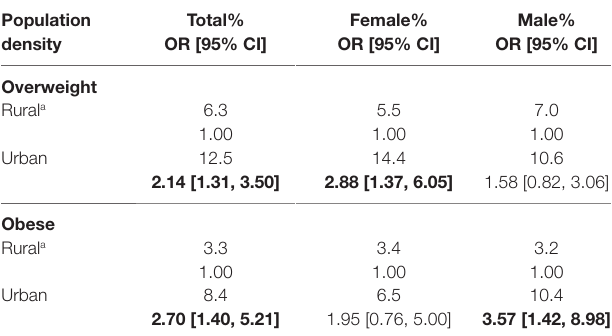
TaBle 5 | Comparison of overweight and obesity prevalence by population density within gender-specific and aggregated groups.